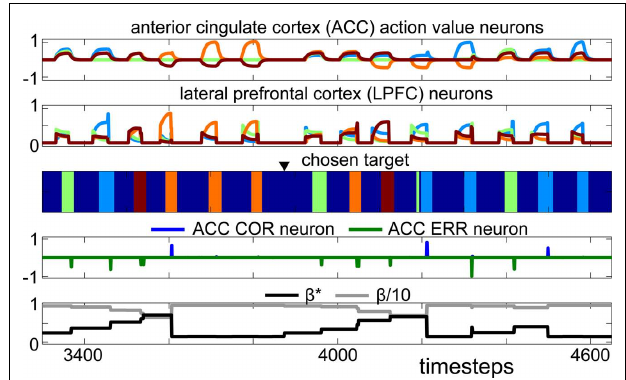
FIGURE 6 | Simulation of the model on two consecutive problems during Experiment 1. Each color represents a different target chosen by the robot.The black triangle above the “chosen target” chart indicates the presentation of the Problem-Changing Cue before the start of a new problem.The x -axis represents time.The first chart shows the activity of ACC action value neurons.The second chart shows LPFC action neurons. The fourth chart shows ACC feedback categorization neurons, indicating errors (ERR) and correct (COR) trials, and induced by dopaminergic reward prediction error signals.The last chart shows the evolution of the exploration rate β in the model.This simulation illustrates the correct execution of the task by the robot and shows the incremental variation of the exploration rate in response to positive and negative feedback.